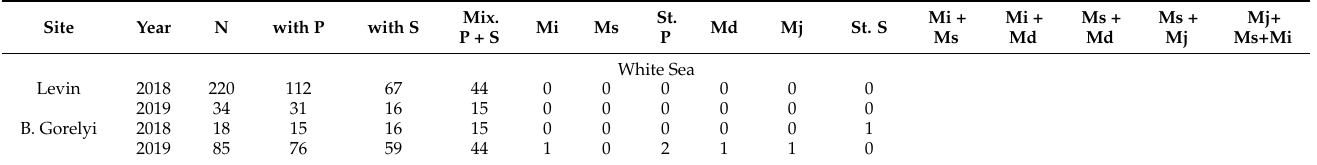
Table 2. Occurrence and prevalence of metchnikovellids and their gregarine hosts in the polychaetes Pygospio elegans collected from the White and Barents